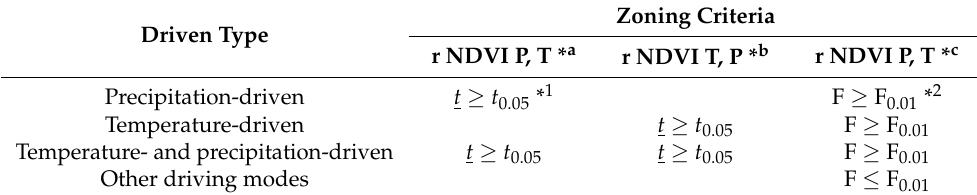
Zoning Criteria